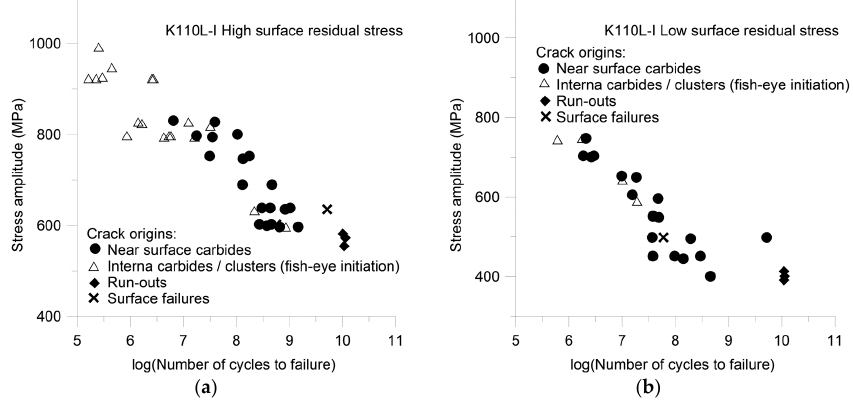
Figure 8. ( a ) Fatigue data of ultrasonic high cycle fatigue tests for AISI D2 steel K110L-I with high surface residual stress after ref. [20]; ( b ) Fatigue data of ultrasonic high cycle fatigue tests for AISI D2 steel K110L-I with low surface residual stress after ref. [20].